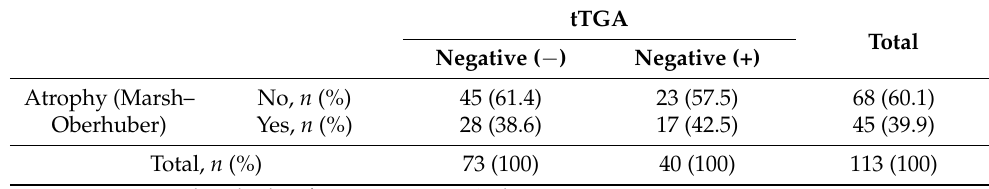
Table 3. Anti-tissue transglutaminase immunoglobulin A (tTGA) and atrophy contingency table.